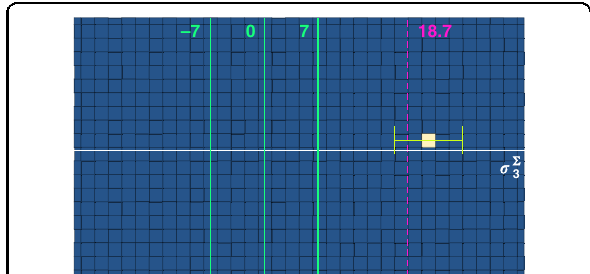
Fig. 1 Single detection event yielding an anomalous weak value . The vertical solid lines show the borders and centre of the of σ Σ 3 eigenvalue spectrum of our observable, while the dashed line indicates its weak value calculated according to the experimental 18 : 7. The experimental point, shown in parameters, i.e., ð σ Σ 3 Þ w ¼ 1 click white, gives the value ð σ Σ ¼ 21 : 4. The uncertainty, represented 3 Þ w by the horizontal green bars, is speci fi ed by calculating the width of the spatial wave function of the quantum particle before the detection, and con fi rmed by repeating the experiment many